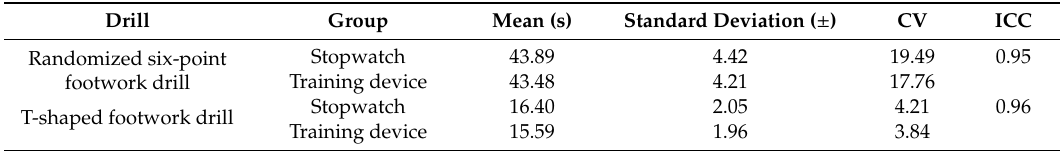
Table 2. Reliability and validity analysis of the measurement produced by the training system and a stopwatch.